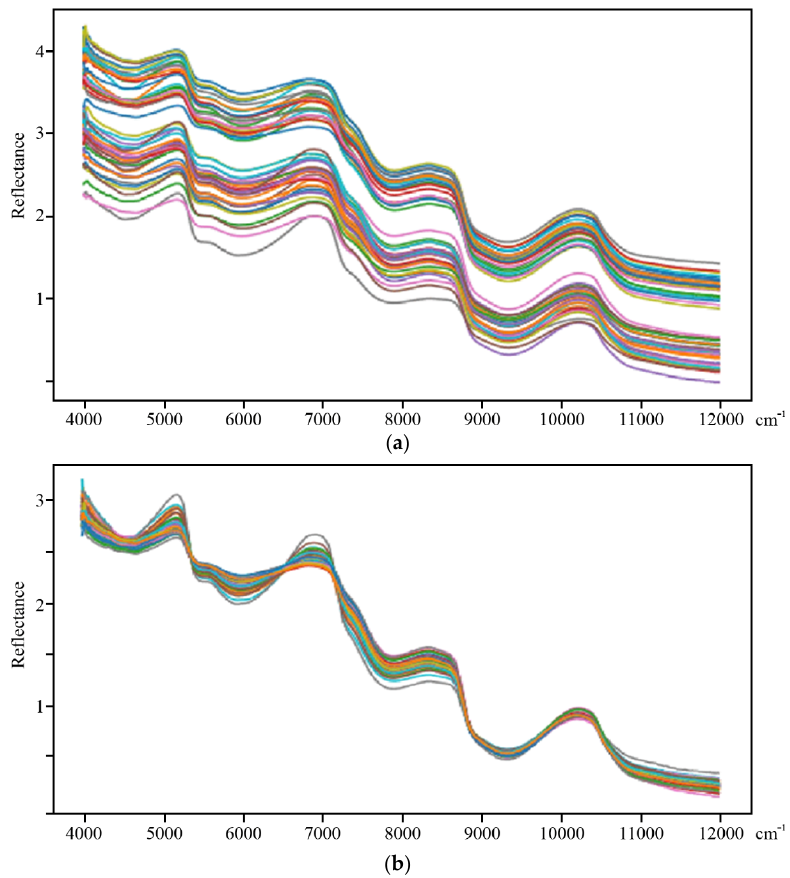
Figure 1. ( a ) Unprocessed and ( b ) MSC-corrected reflection FT-NIR spectra of intact grape berries.